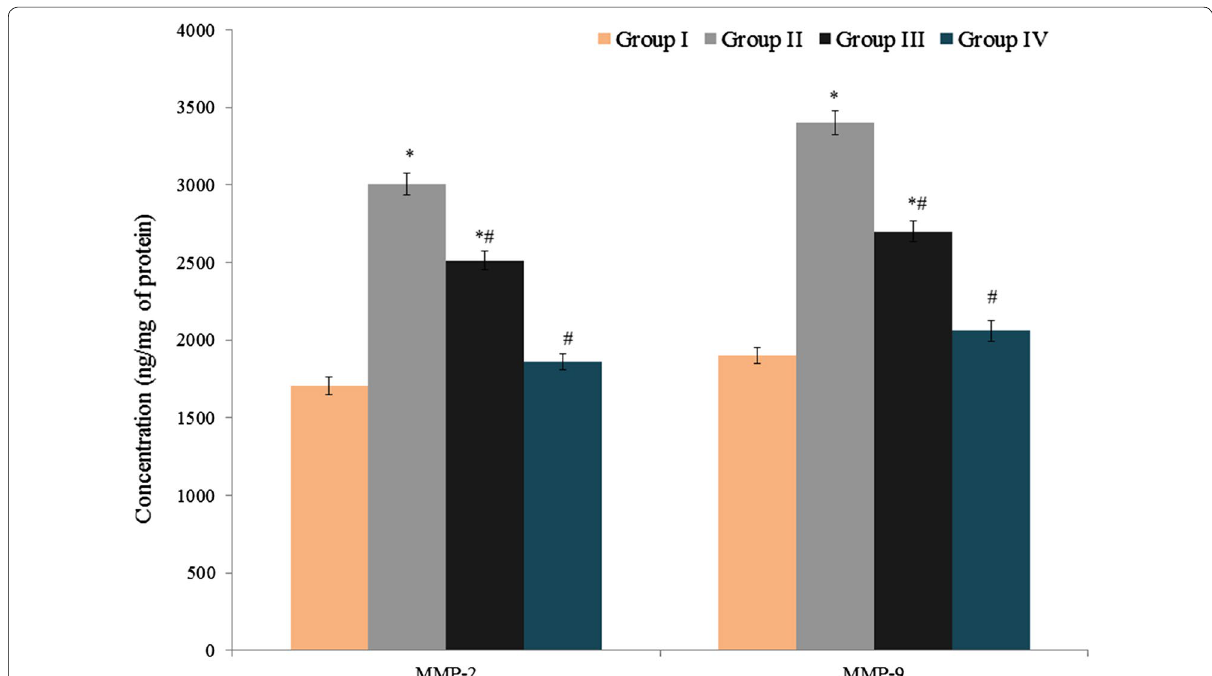
Fig. 2 Effect of atorvastatin and amygdalin on matrix metalloproteinase-2 (MMP-2) and MMP-9 in the peritoneal fluid of Sprague-Dawley rats with experimentally induced endometriosis. Values are expressed in ng/mg of protein. * P < 0.05 vs. group I (sham-operated rats) and # P < 0.05 vs. group II (non-treated endometriosis control